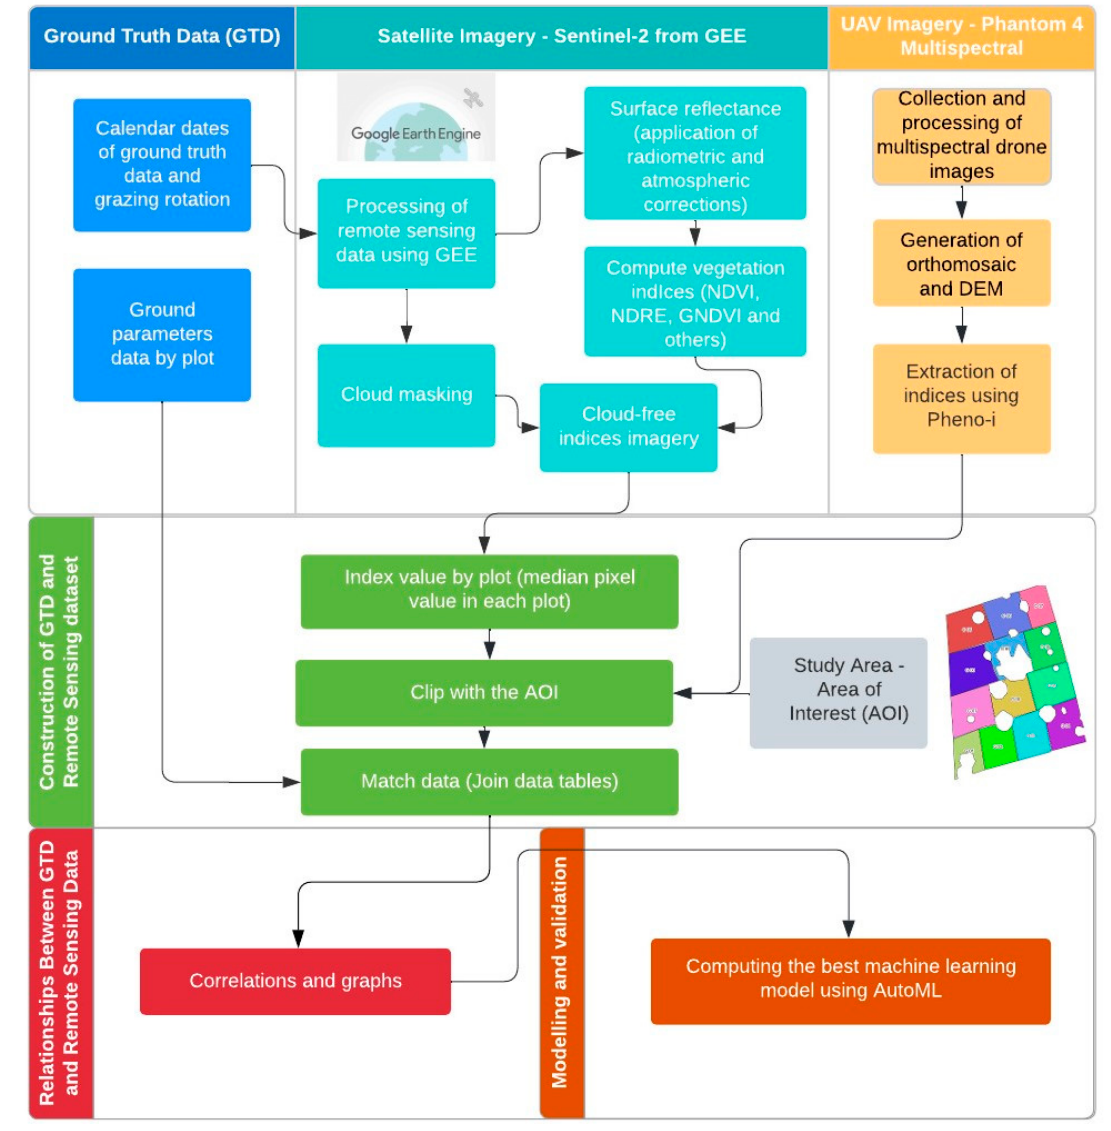
Figure 4. Workflow of the project.